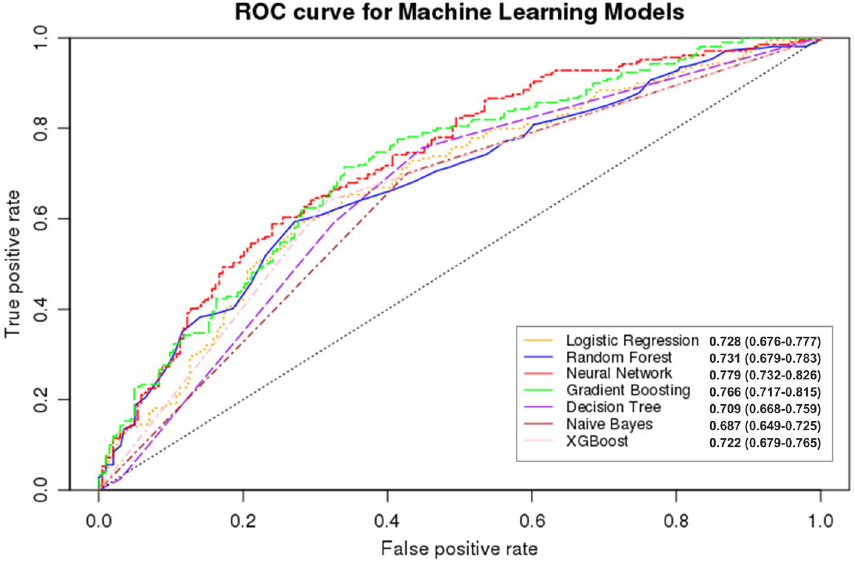
Figure 1. Receiver operating characteristic curve for the Parkinson’s disease prediction performance of each algorithm.